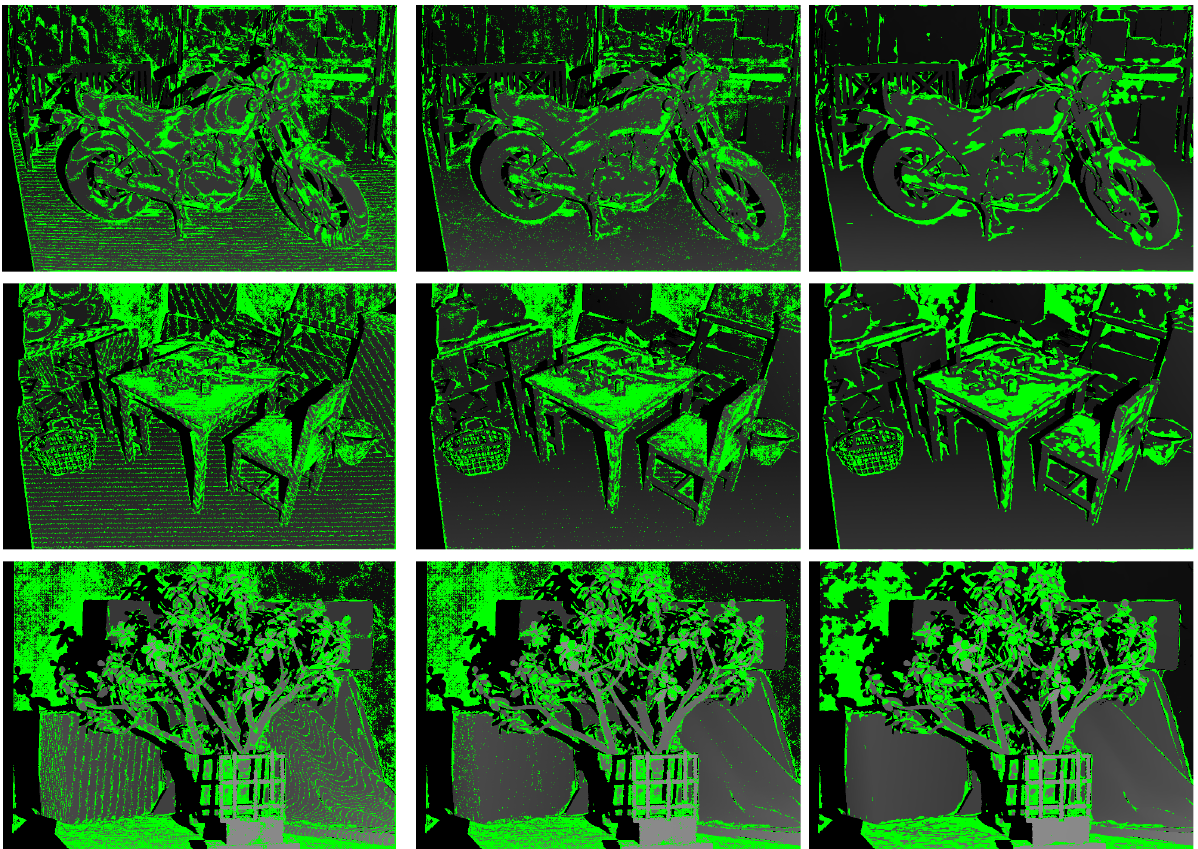
Figure 1. Estimated disparity maps using SGM-SAP. Left : disparity maps without any refinement; centre: sub-pixel interpolation; right: median filtering. Differences above 0.5 pixel from the ground truth are highlighted in green. Top to bottom : Motorcycle , PlaytableP and Jadeplant